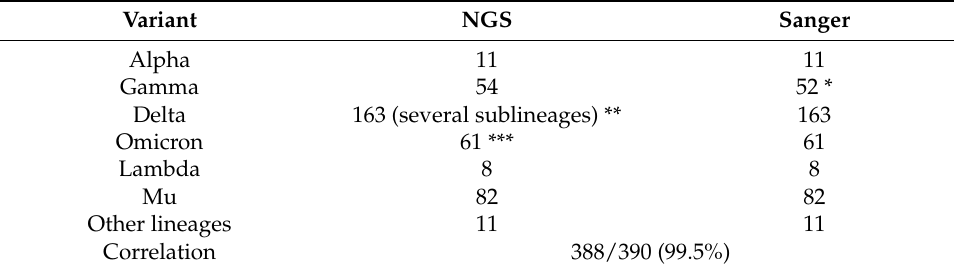
Table 2. Correlation between variant assignment by Sanger and NGS sequencing.